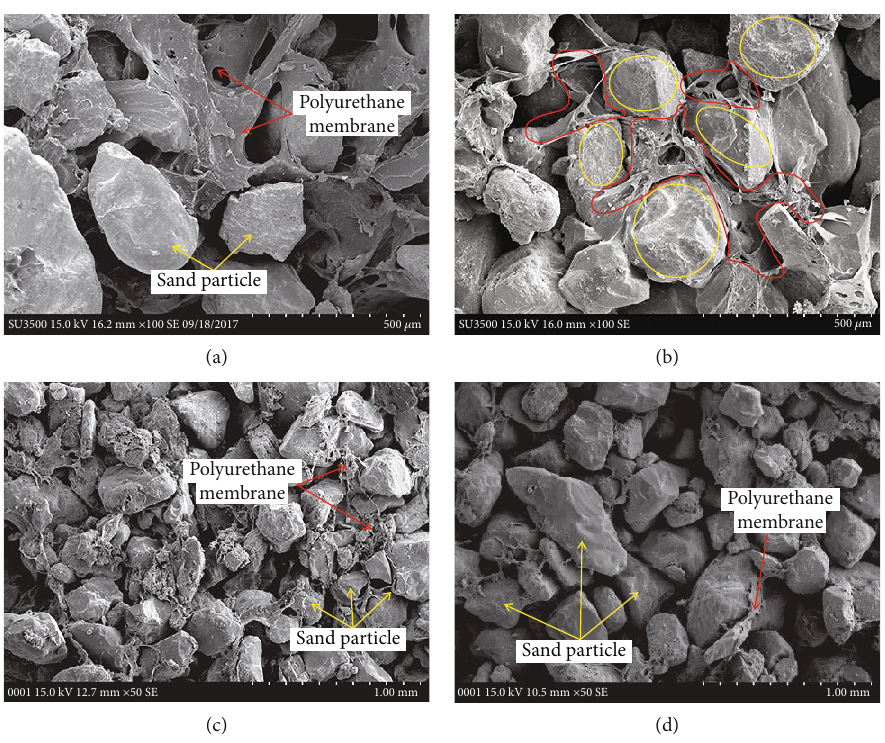
Figure 13: The scanning electron microscope images of the PU-sand mixture: (a) with 4% PU at 100x magni fi cation; (b) with 2% PU at 100x magni fi cation; (c) with 2% PU at 50x magni fi cation; (d) with 1% PU at 50x magni fi cation.